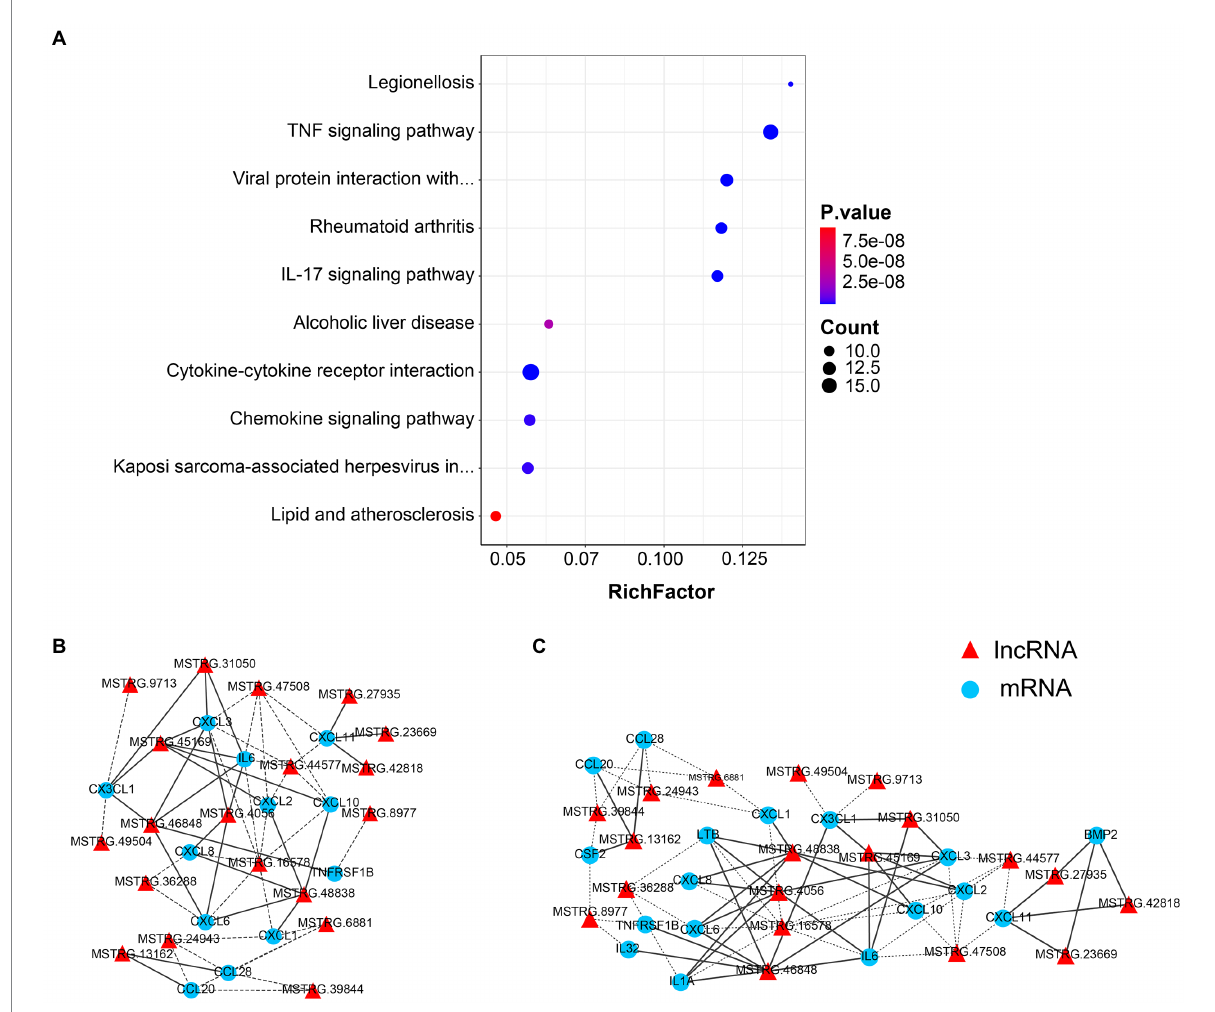
FIGURE 6 Co-expression analysis of lncRNAs and protein-coding genes. (A) The top 10 over-represented KEGG pathways of co-expressed genes. The network of lncRNAs with (B) viral protein interaction with cytokine and cytokine receptor, and (C) TNF signaling pathway-related genes ( p < 0.01). The solid line represents a positive correlation, while the dotted line represents a negative